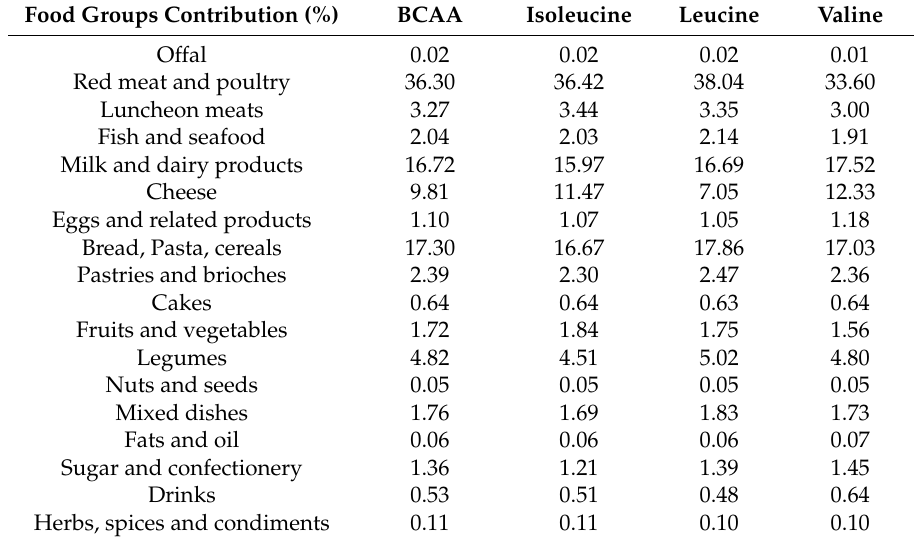
Table 4. Contribution of food groups to total and individual BCAA intake in SPI